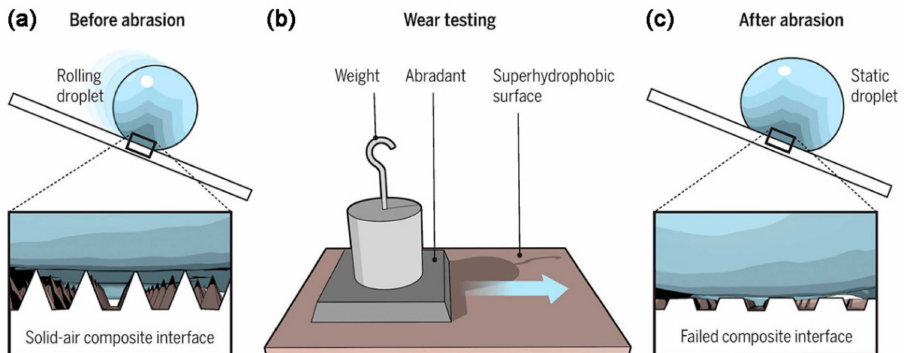
Figure 16. Linear abrasion test. ( a ) A water droplet rolls on a nonwetting surface; ( b ) The setup and process of linear abrasion test; ( c ) The structures are worn out after linear abrasion cause that the surface may lose water repellent property. Adapted with permission from. Reprinted from [90], Copyright (2016), with permission from